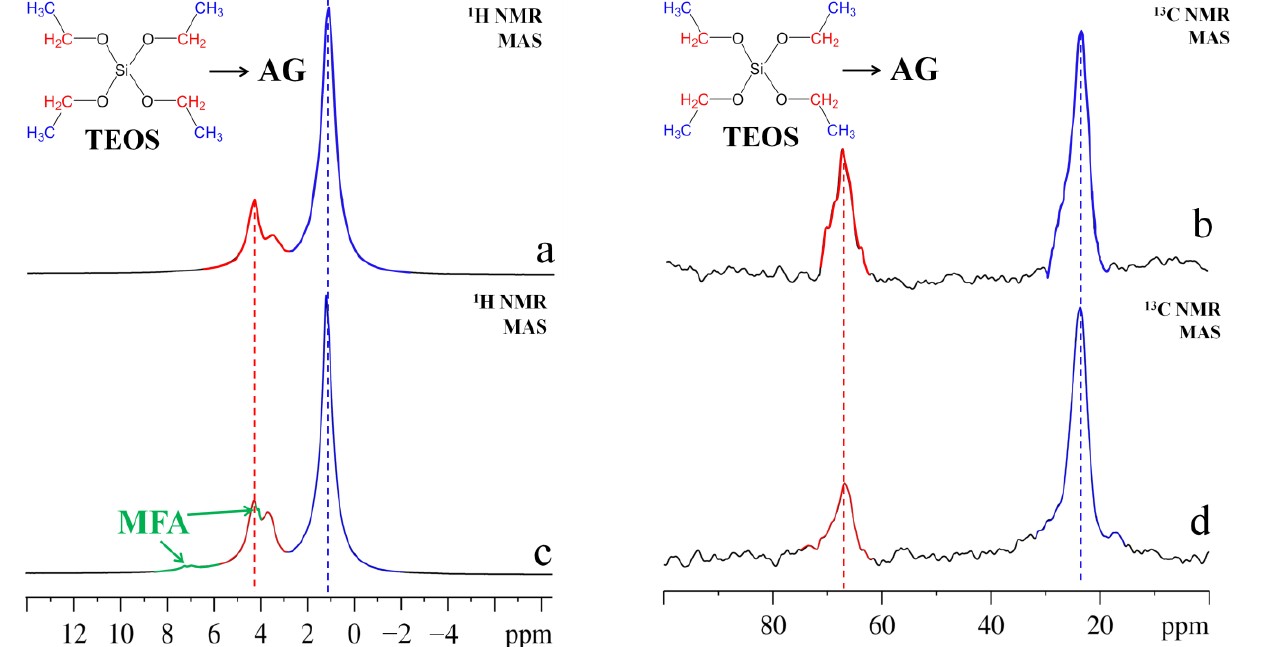
Figure 1. The 1 H and 13 C MAS NMR spectra of the original undoped SiO 2 -based aerogel and aerogel doped with mefenamic acid are shown in ( a , b ) and ( c , d ), respectively, after drying in scCO 2 medium. The signals corresponding to the hydrogen atoms ( a ) and carbon ( b ) of the CH 2 groups of the precursor TEOS are marked in red, the signals of the CH 3 groups of the precursor TEOS are marked in blue, and the signal belonging to the hydrogen atoms of the aromatic and OH/NH fragments of mefenamic acid (MFA) is marked in green.